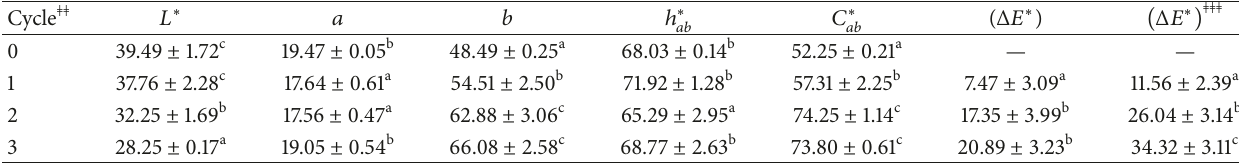
Table 1: Color evaluation in fresh and concentrate orange juice (cid:2) .